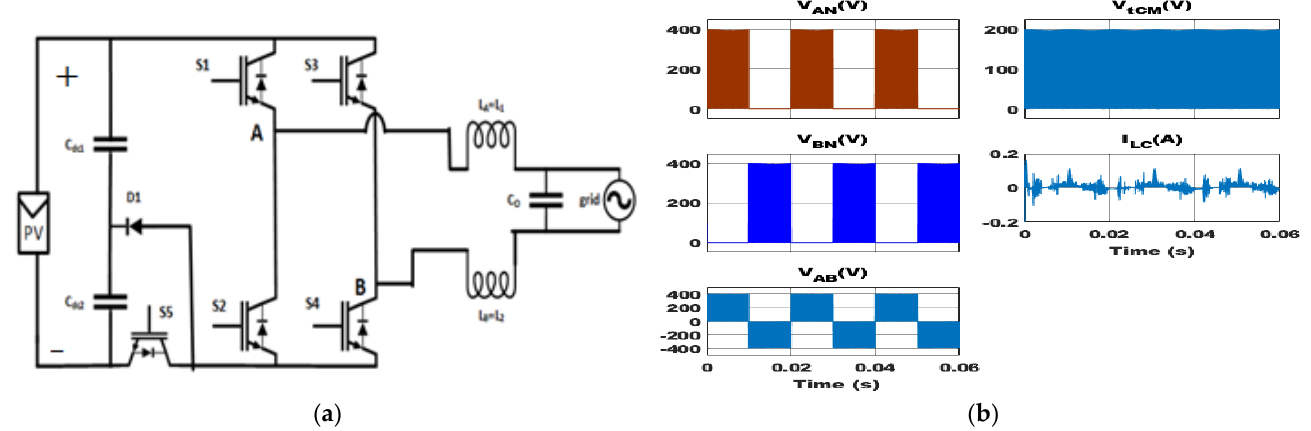
Figure 15. H5-D topology: ( a ) circuit structure; ( b ) simulation results.